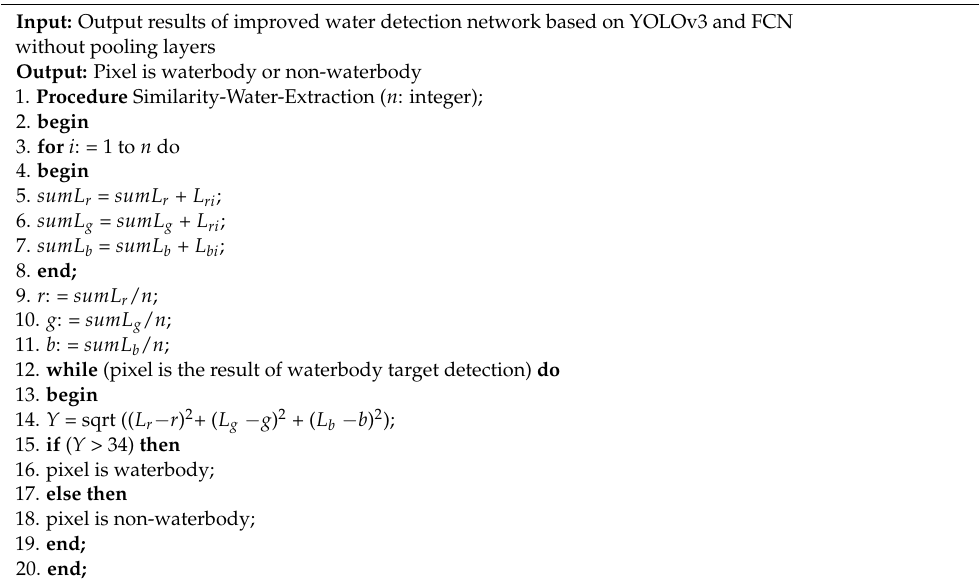
Algorithm 1. Similarity Algorithm for Water